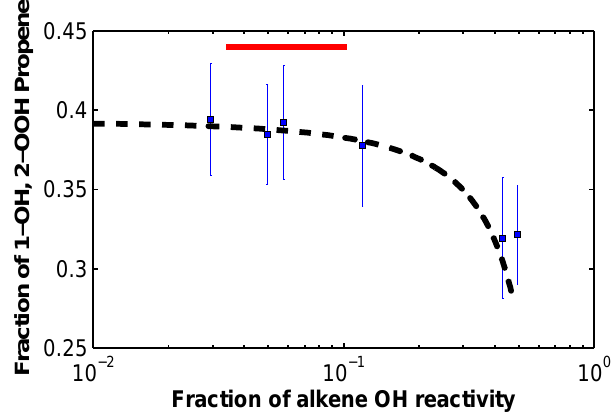
Figure 7. The measured isomer distribution of propene hydroxy hydroperoxides (blue boxes) as a function of the initial alkene OH reactivity and the initial hydrogen peroxide concentration. The red line represents the alkene OH reactivity regime over which hydroxy hydroperoxide isomer distributions were reported for all alkenes other than propene. The dashed black line represents a ki- netic box model simulation designed to study the maximum impact RO 2 +RO 2 chemistry might have on the isomer distributions. See Appendix B for further details on the kinetic model.